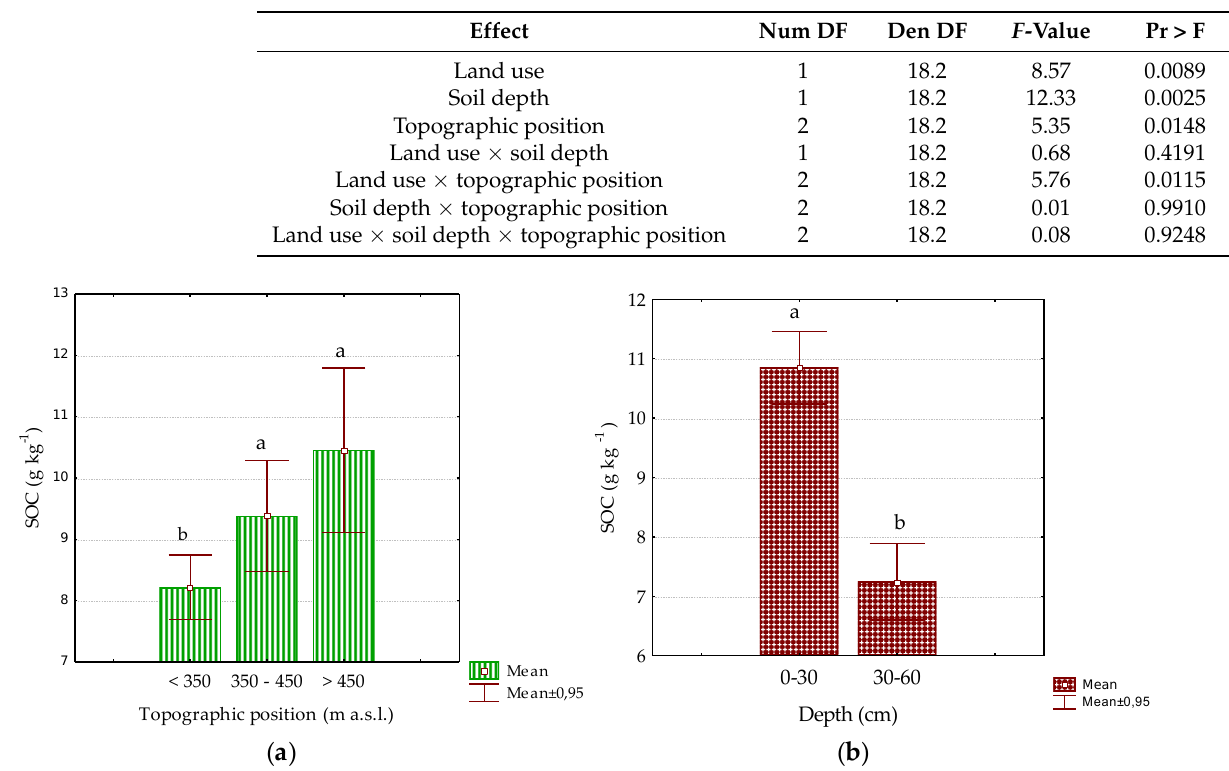
Figure 8. Soil organic carbon content: ( a ) for different topographic positions, p < 0.05; ( b ) in soil layers, p < 0.01 Significant differences between soil groups are labeled with different letters, (N = 60).